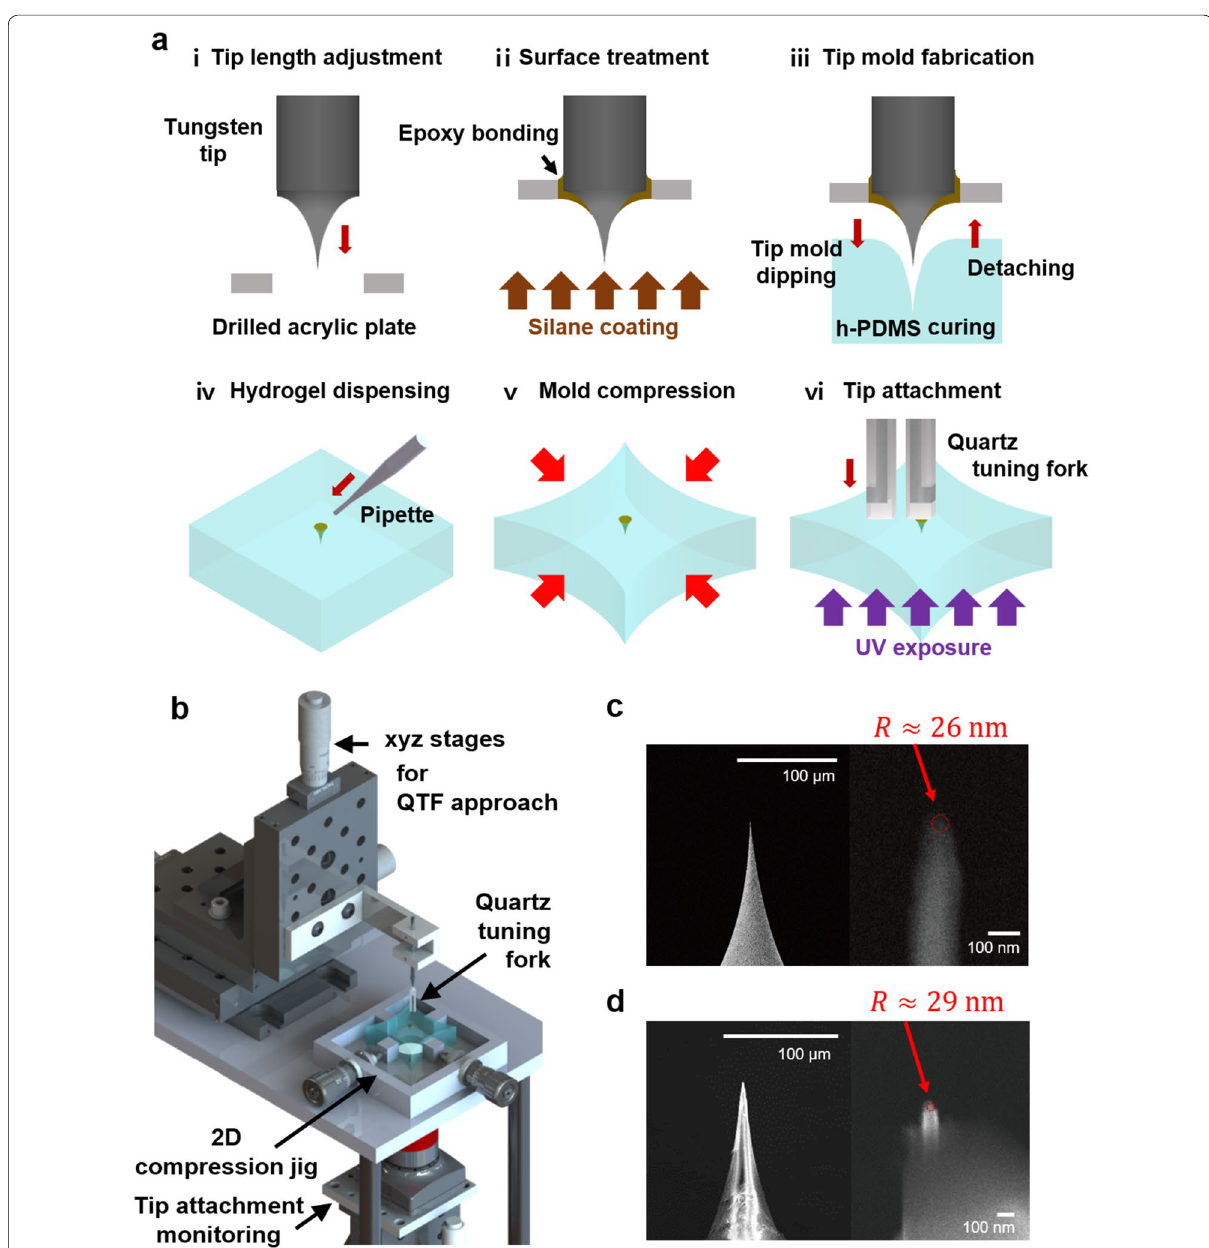
Fig. 2 Tip attachment process, setup, and results. a Process of making conical tip mold and attachment of hydrogel (PEGDA) tip onto quartz tuning fork. b 3D CAD drawing of the tip attachment setup with the mold compression jig. SEM images of c an electrochemically etched tungsten wire and d a PEGDA tip replicated from the etched tungsten wire and attached to quartz tuning